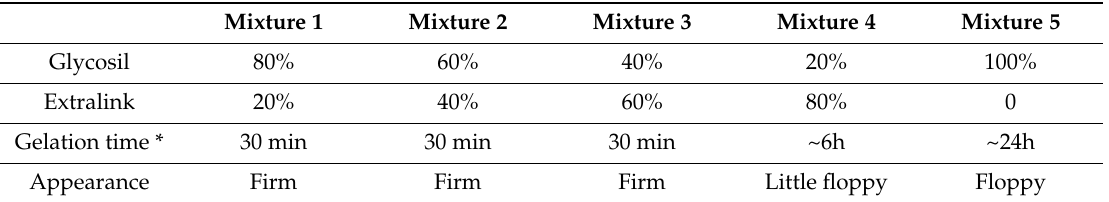
Table 1. The ratios of components in preparing hyaluronan (HA) hydrogel sca ff olds for the first set of experiments. Mixture 1 Mixture 2 Mixture 3 Mixture 4 Mixture 5 Glycosil 80% 60% 40% 20% 100% Extralink 20% 40% 60% 80% 0 Gelation time * 30 min 30 min 30 min ~6h ~24h Appearance Firm Firm Firm Little